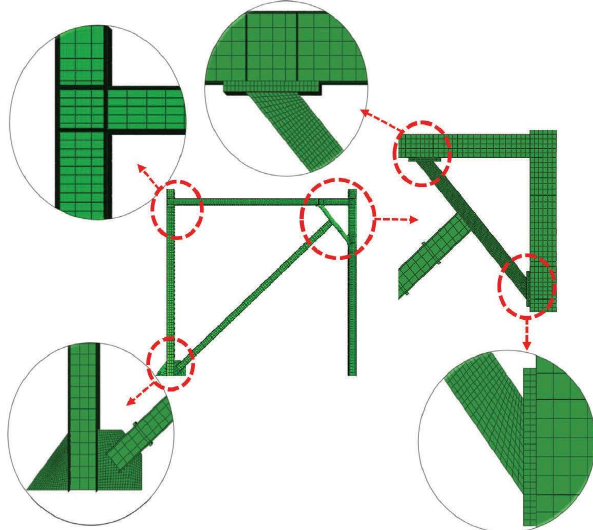
Figure 4: FEM modeling of the KBF system in ABAQUS.